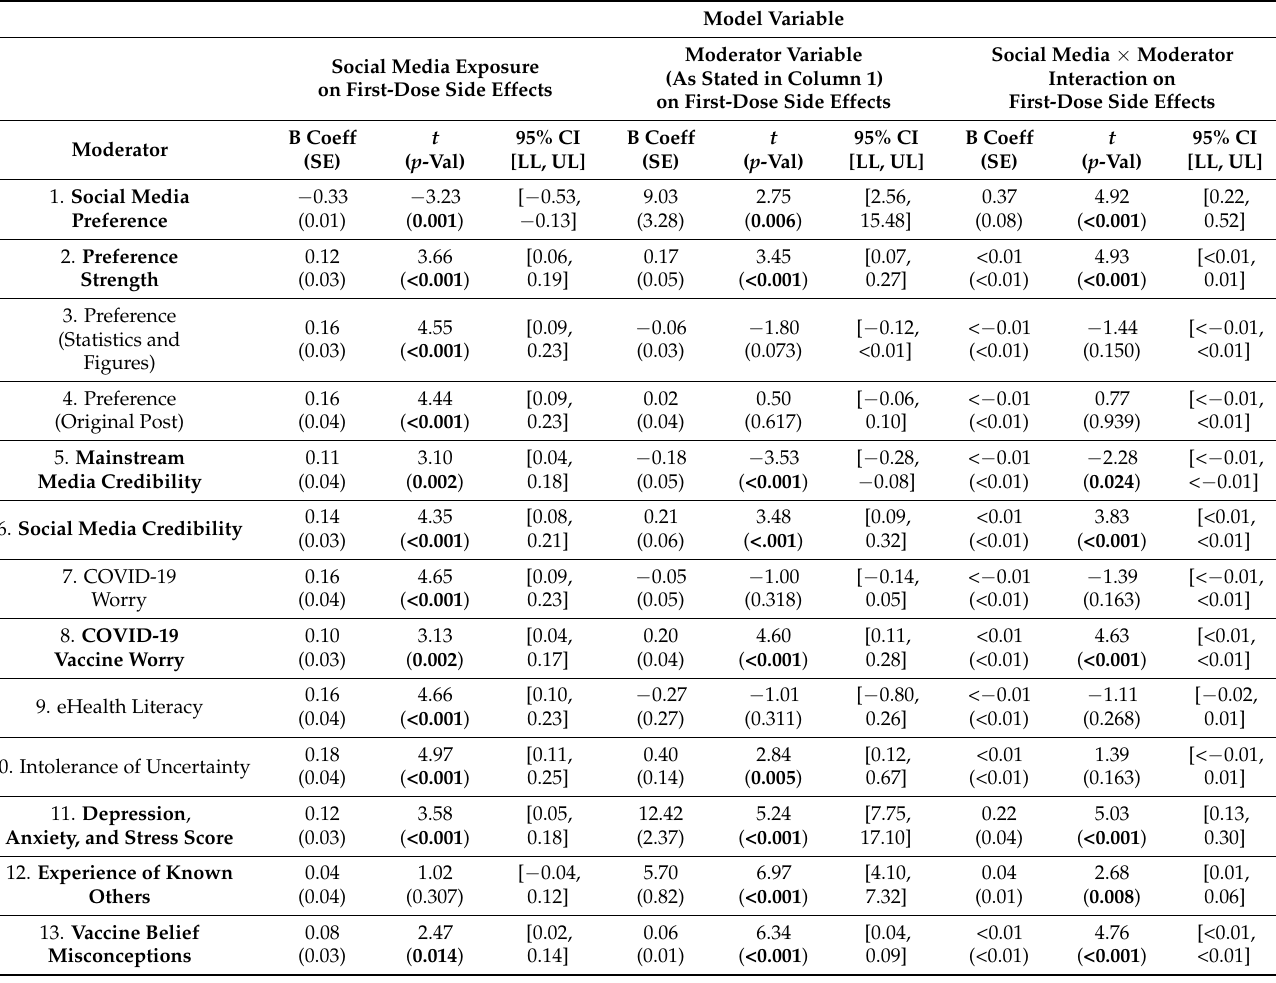
Table 2. First dose moderation analyses—bold variables are significant moderators (note: each moderator was investigated in separate moderation models).